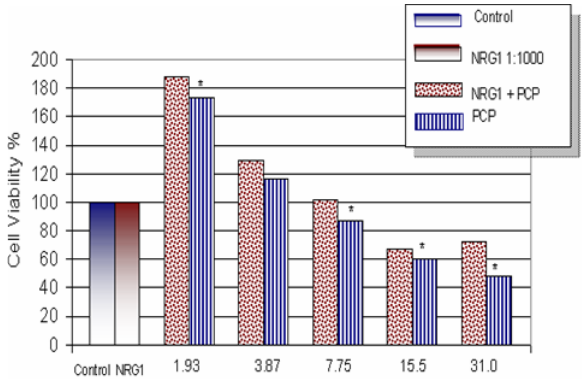
Figure 3: Expression and relative abundance of the 62 kDa c-fos in AML 12 mouse hepatocytes exposed to PCP and NRG1- β + PCP for 48 h. AML 12 mouse hepatocytes were treated with 8 µg/mL and 16 µg/mL concomitant treatments of PCP and NRG1- β + PCP. c-